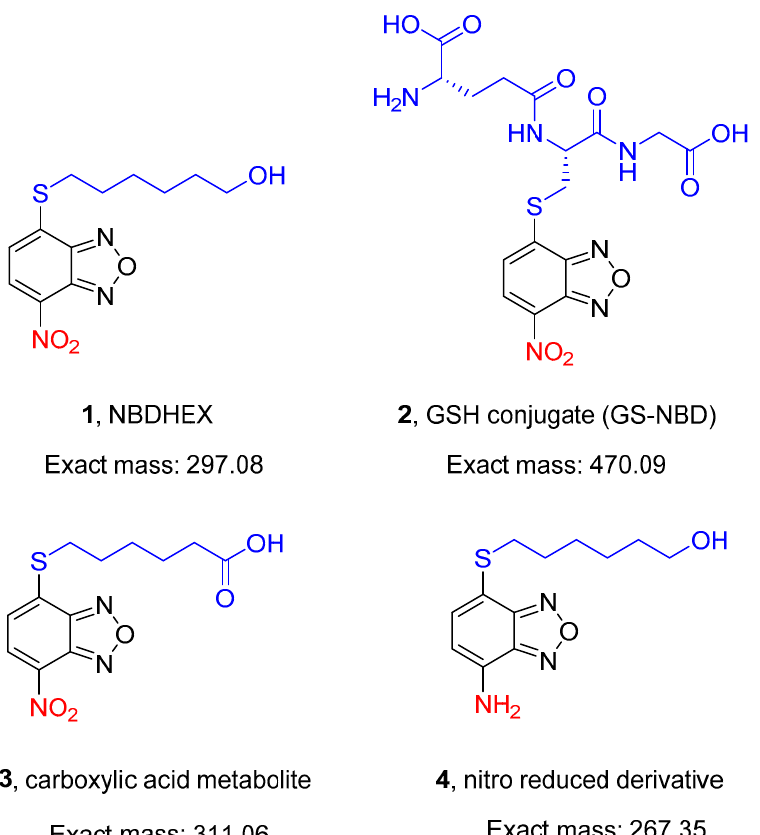
Figure 1. Structures of the compounds ( 1 – 4 ) evaluated in the present study.